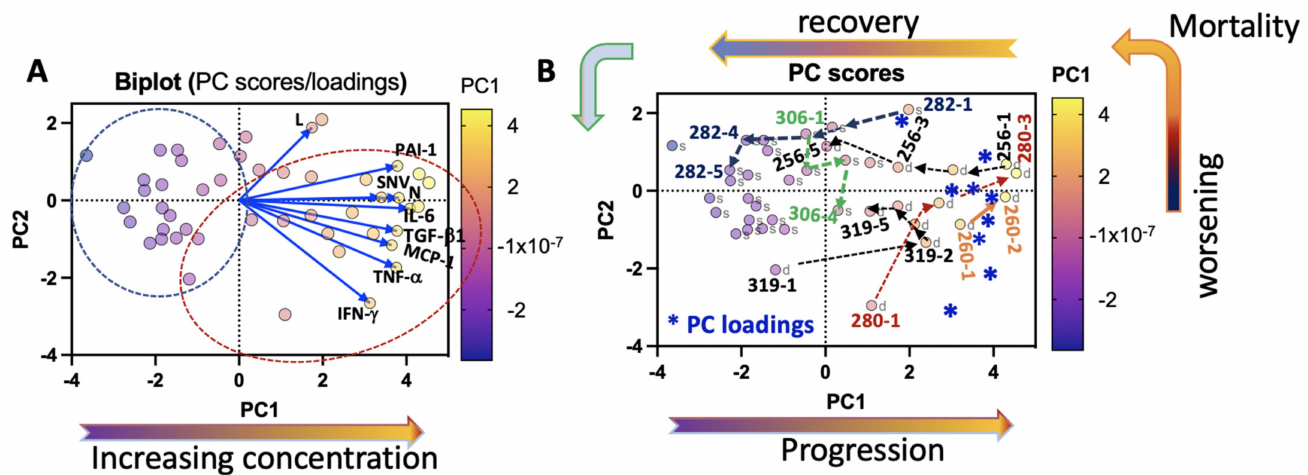
Figure 6. Principal Component Analysis (PCA) of patient variables, IFN- γ , IL-6, MCP-1, TNF- α , PAI-1, TGF- β 1, SNV, N, and L, distinguishes survivors and decedents. ( A ) Biplot of PC scores graph and loadings. The PC scores data points are color-coded based on their magnitude on the PCA1 color scale. The loadings data are attached to the blue vectors and represent patient variables. The magnitude and direction of the vectors represent the correlation between the loadings and the PC scores. The angle between two vectors is proportional to the degree of correlation for different vectors, with smallest angles meaning high correlation, orthogonal (90 ◦ ) as uncorrelated, and opposing (180 ◦ ) as negatively correlated. ( B ) PC scores plot identifies survivors (s) and decedents (d). Class III cases are displayed as case numbers on different days. Dotted lines connect longitudinal data points and show a directional change in immune response and correlated loading variables ( * displayed as vectors in Figure 6A). The original Biplot and PC scores figures were produced in GraphPad Prism version